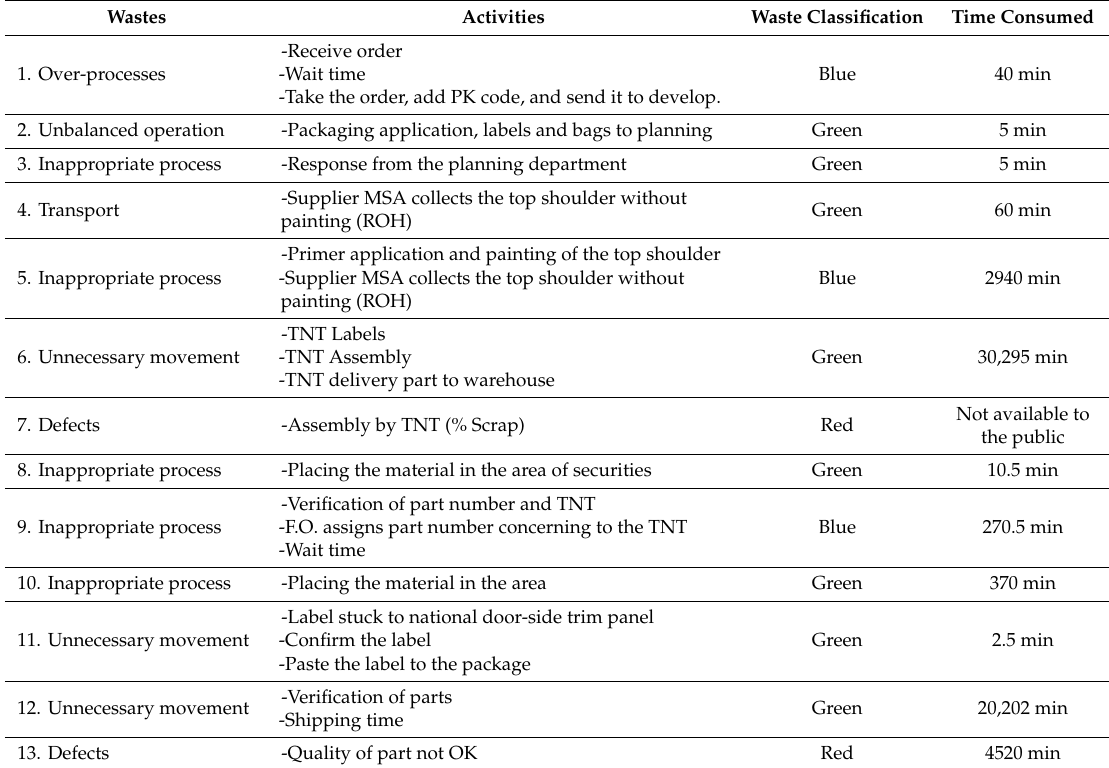
Table 3. Identification and classification of wastes.